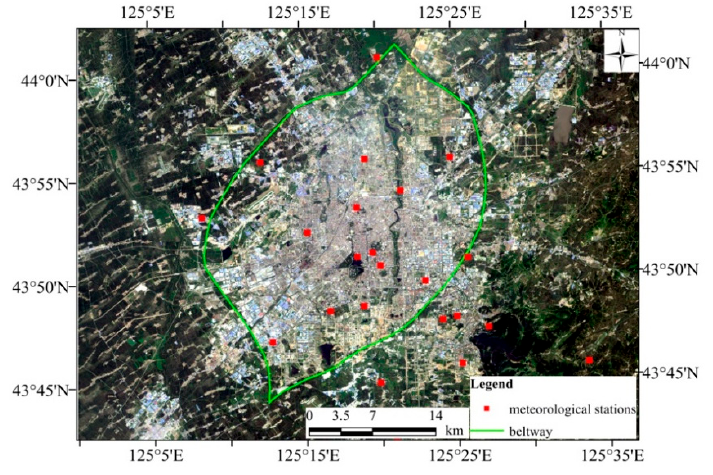
Figure 15. The distribution of the meteorological stations. Table 8. Comparison of the calculation results of the three algorithms with local meteorological